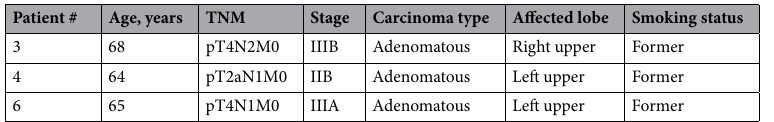
Table 2. Characteristics of the 3 NSCLC patients included in this